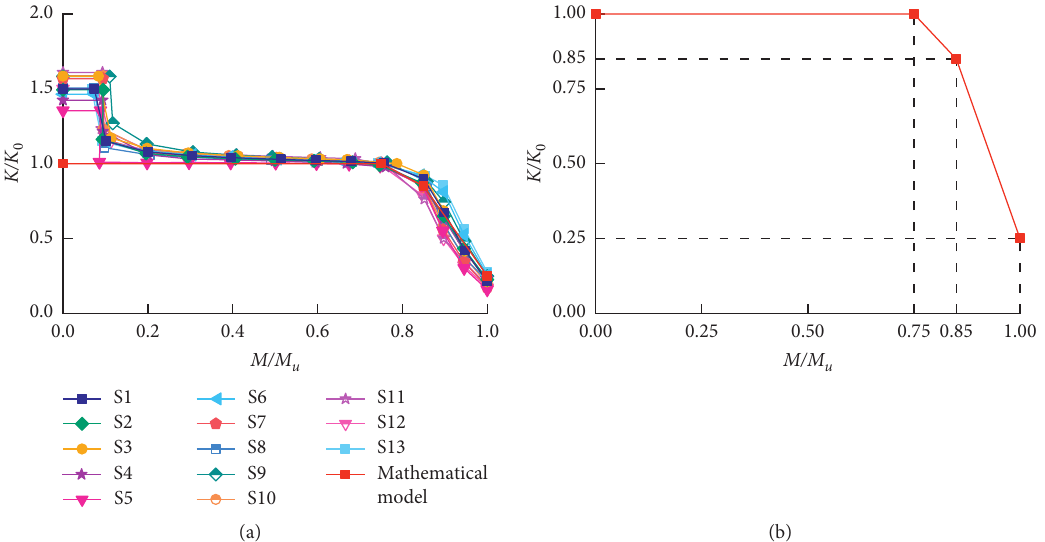
Figure 17: Relationship between moment and sectional rigidity. (a) Normalized curves. (b) Mathematical